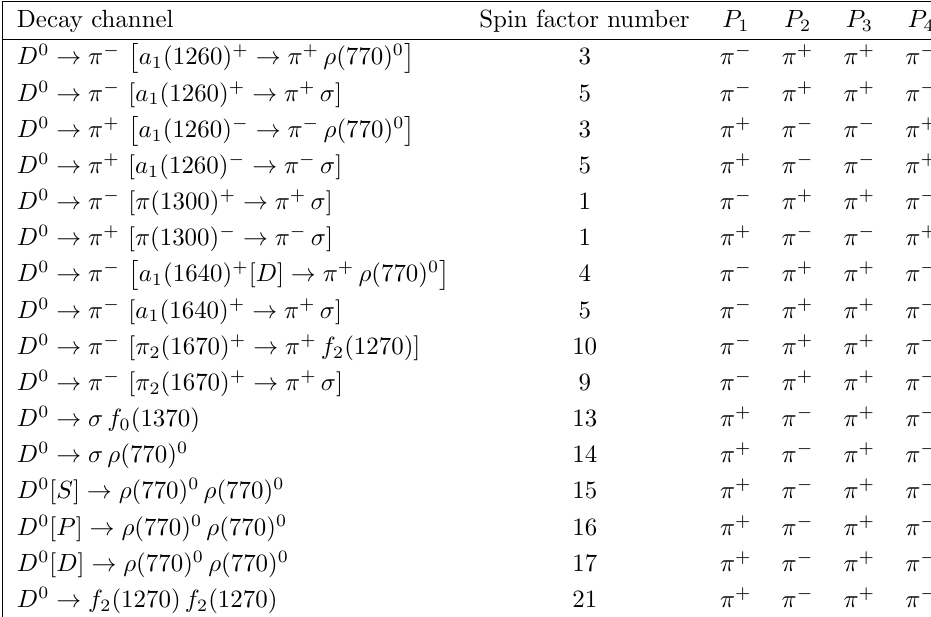
Table 14 . Spin factors used for the decay chains included in the D 0 ! (cid:25) + (cid:25) (cid:0) (cid:25) + (cid:25) (cid:0) LASSO model, including the particle numbering scheme. The second column refers to the spin factors as numbered in table 13, and the particles P 1 , P 2 , P 3 , and P 4 refer to those de(cid:12)ned in table 13. Decay channel